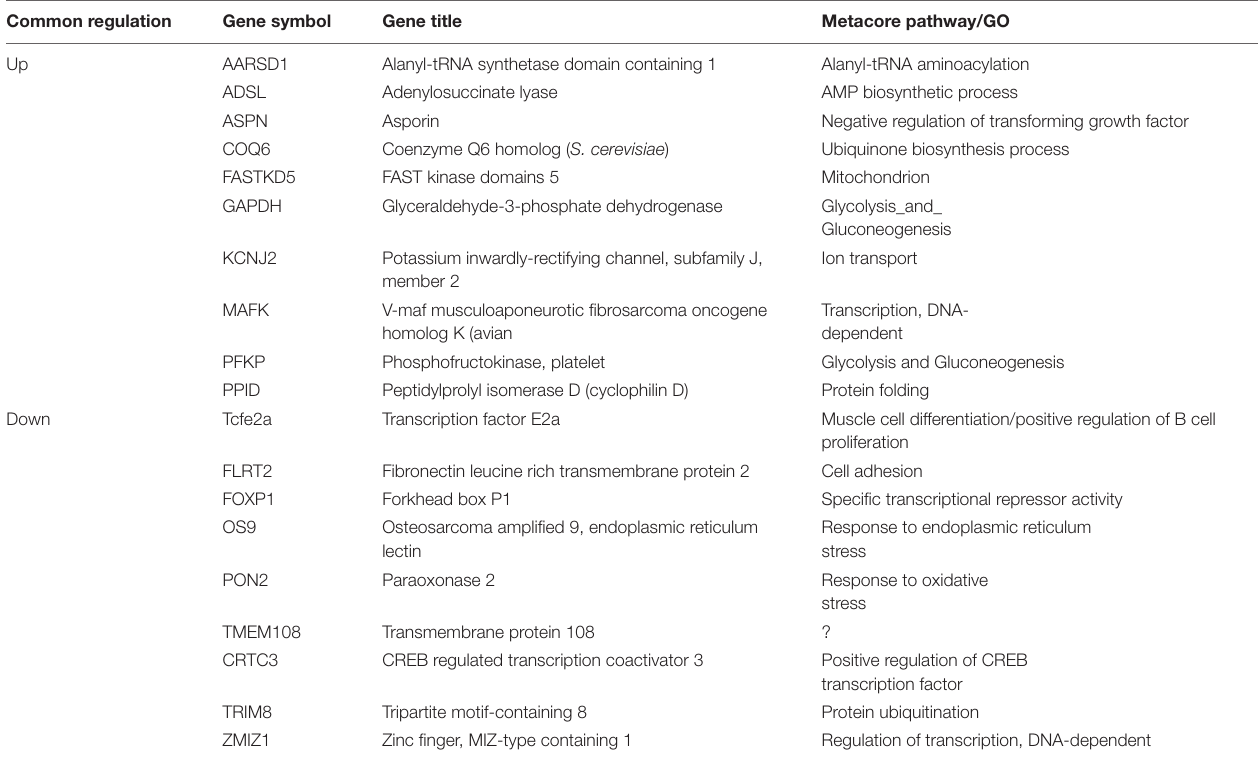
TABLE 3 | Rat ATR vs. Human AF; commonly regulated genes.